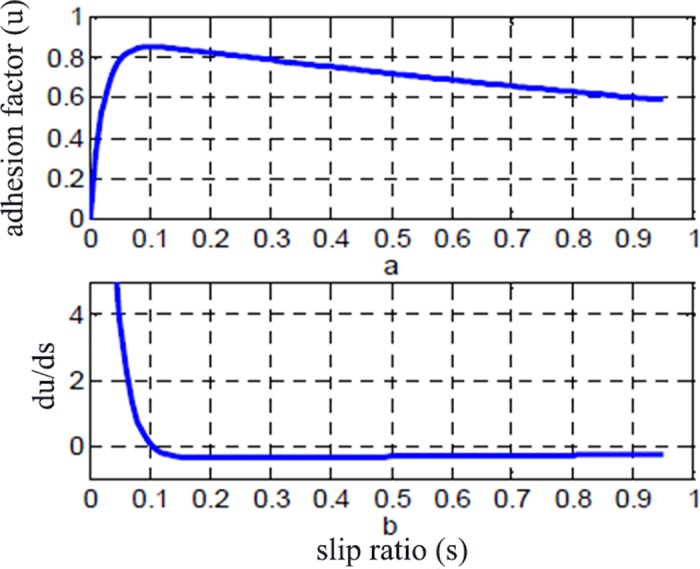
Relations for adhesion coefficient and slip ratio:(a) adhesion factor with slip ratio; (b)du/ds with slip ratio.